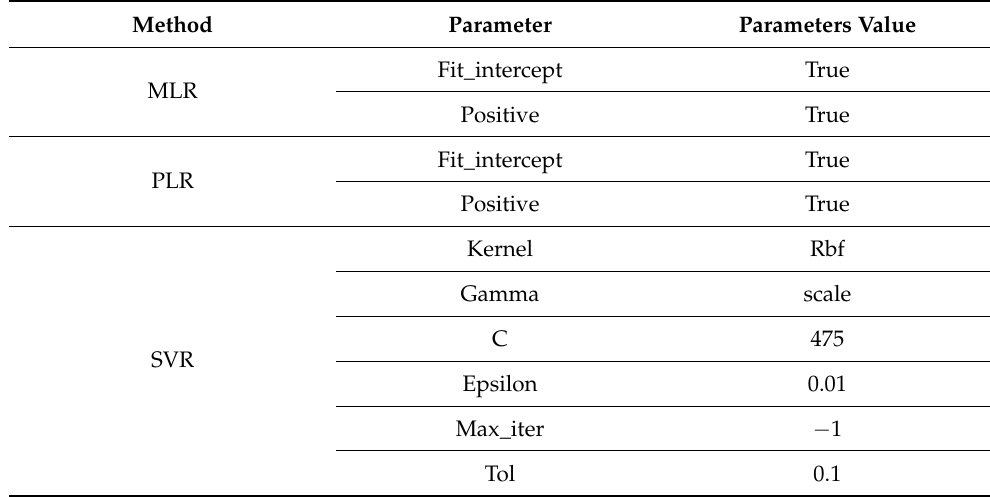
Table 2. All methods parameters optimized.